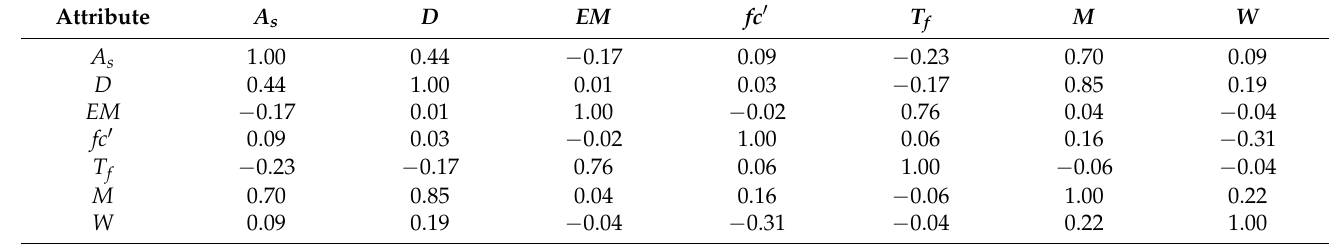
Table 4. Correlation matrix among variables used in the development of models.